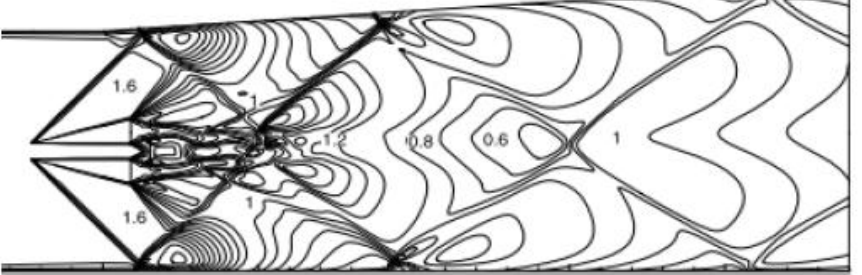
Figure 4. Shock interaction on cold flow mixing for a single strut ( left ) and a twin strut ( right ). Study reported in Reference [3] (copyright ASCE library, 2015).